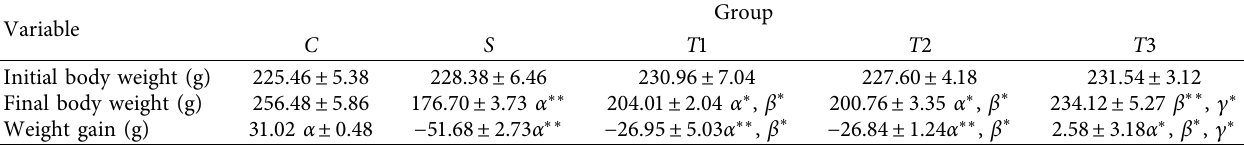
Table 1: Initial, final weight, and weight changes at the end of the study in groups.